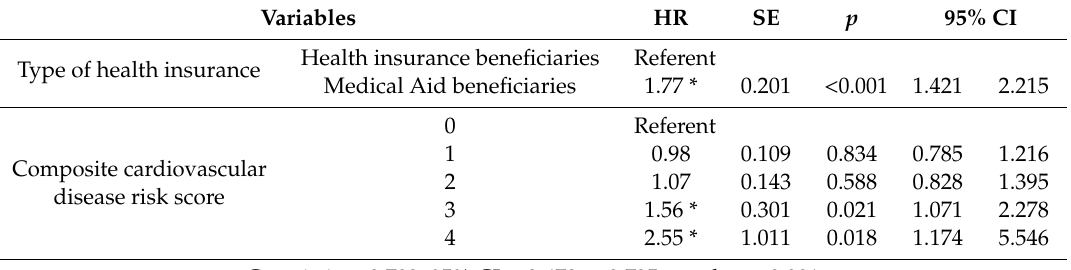
Table 3. Cox proportional hazards model for the association between health insurance, cardiovascular risk factors, and dementia incidence ( N =